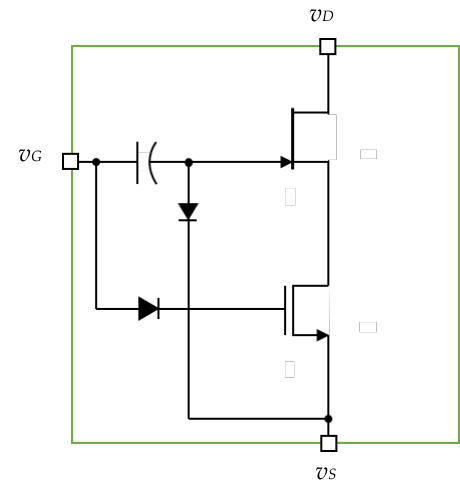
Figure 1. The cascode GaN HEMT power module.